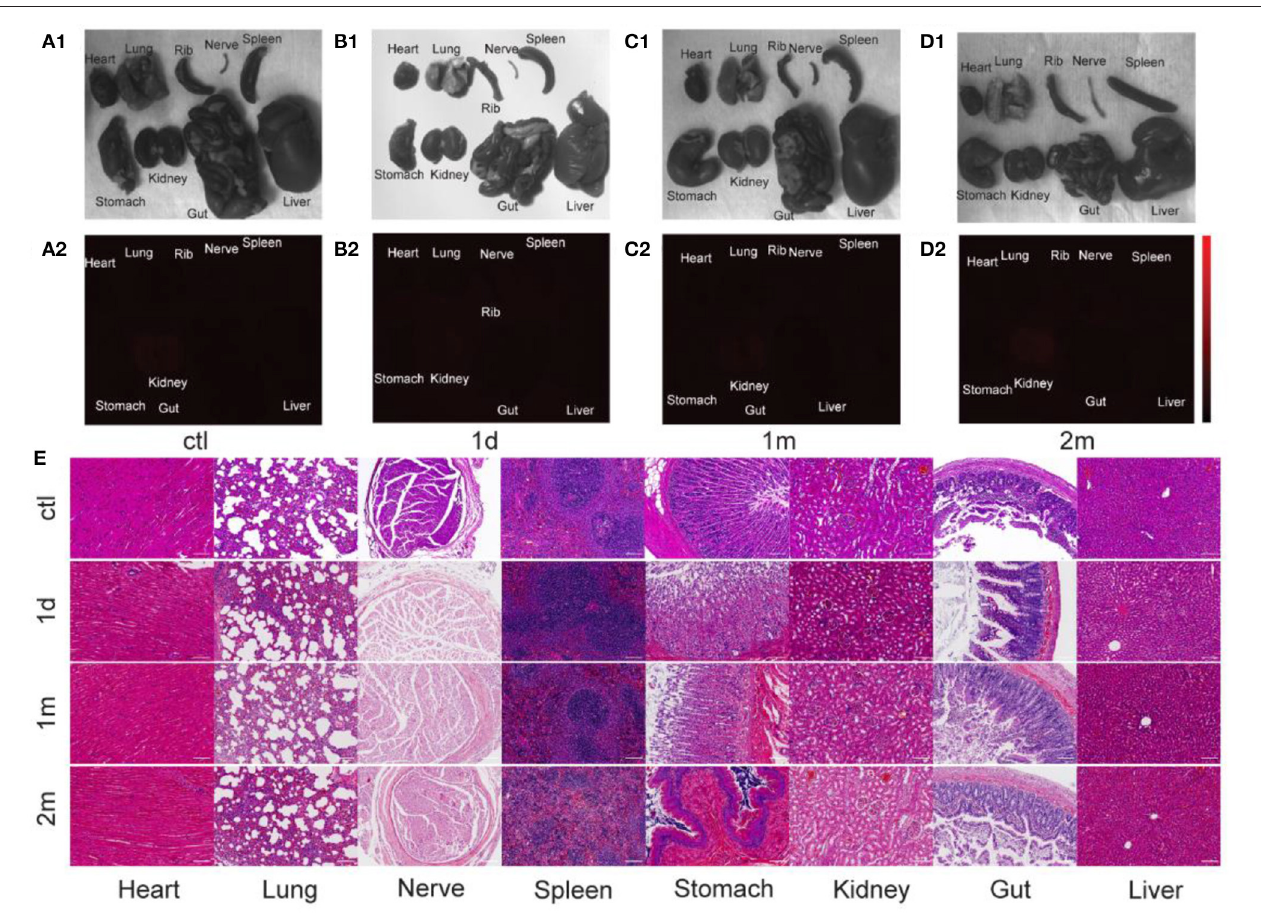
FIGURE 6 | Biosafety of PbS QDs labeled ADSCs. (A1–D1) Bright field photographs and (A2–D2) NIR-II fluorescence images of major organs harvested from the rats in the control group and experimental group at 1 d, 1m, and 2m post-injection. (E) Representative HandE staining of major organs (collected and at 1 d, 1m, and 2m post-injection) of the rats injected with PbS QDs labeled ADSCs and the control group (scale bars represent 100 µ m).